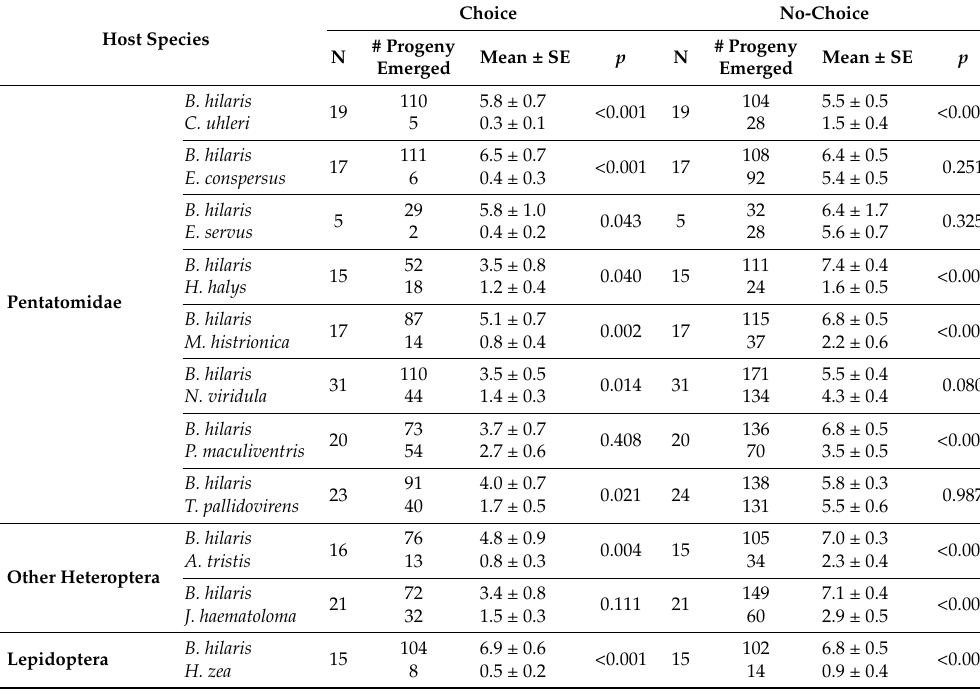
Table 3. Mean ( ± SE) number of progeny emerged from 10 host eggs exposed to one Ooencyrtus mirus adult female for 24